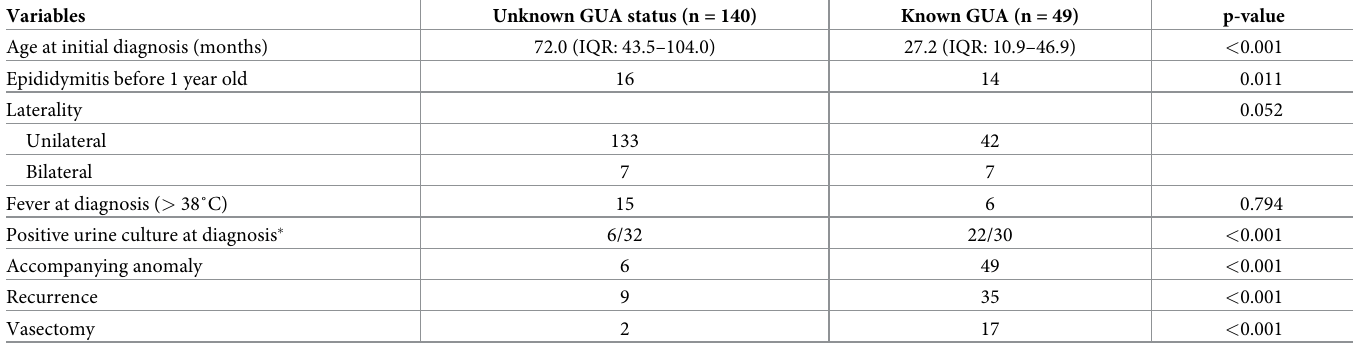
Table 2. Comparison of clinical parameters between AE patients with known genitourinary anomalies and those with unknown genitourinary anomaly status (N =